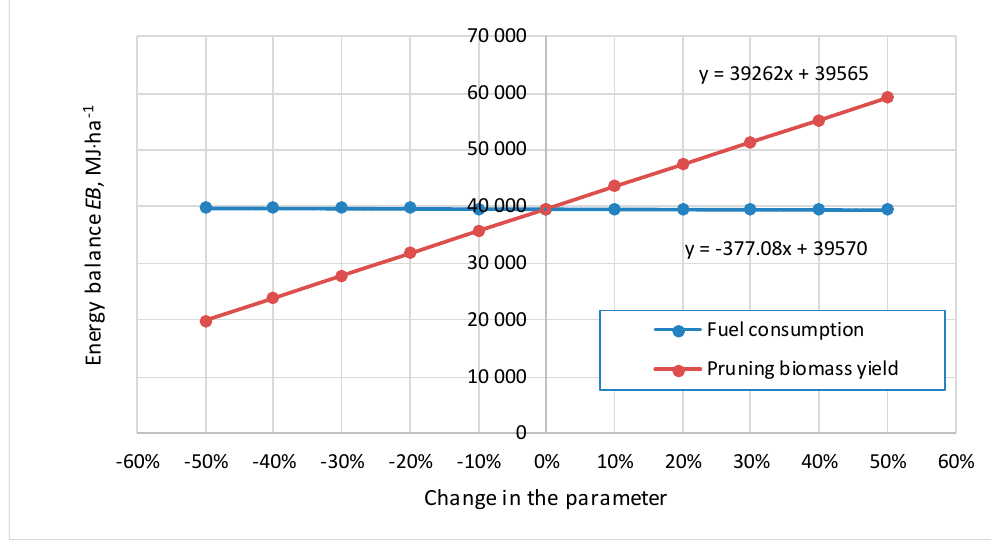
Figure 4. Sensitivity analysis of the main parameters influencing EB